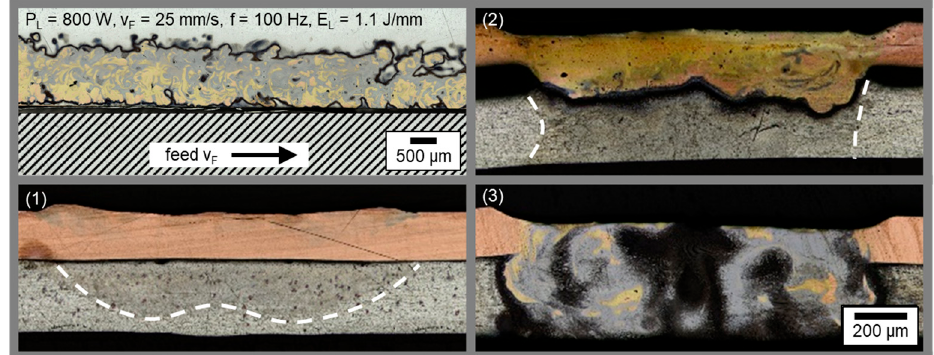
Figure 10. Micrographs (transversal section (top left) and cross sections at a distance of 2 mm (1), 16 mm (2), and 30 mm (3) from the starting point of the welding process) of Cu-Al joint welded with vertical eight beam oscillation at P L = 800 W, v F = 25 mm/s, f = 100 Hz.